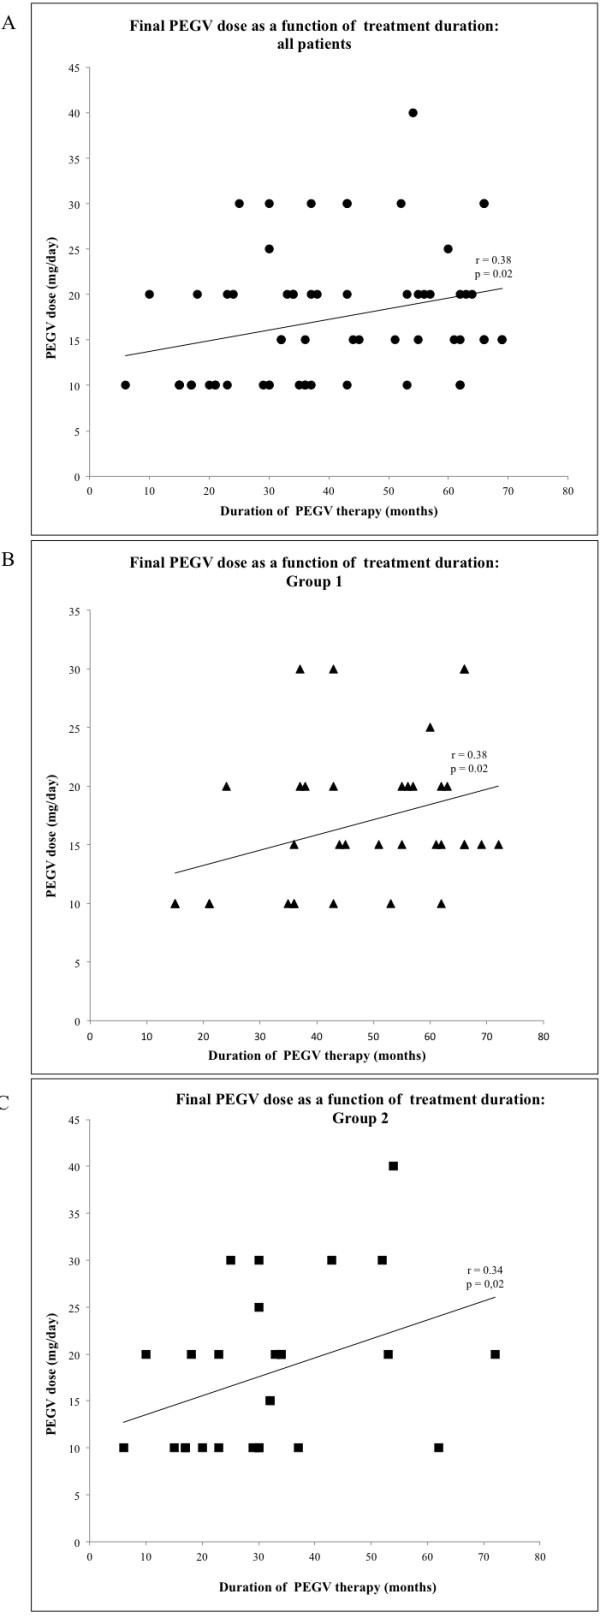
Relationship between duration of PEGV therapy and final daily dose according to treatment regimen. Correlation between duration of PEGV therapy (months) and final daily PEGV dose (mg/day) in the total study population (A, upper panel, ●), Group 1 (B, middle panel, ■), and Group 2 (C, lower panel▲). Regression coefficients (r) and p values are shown.